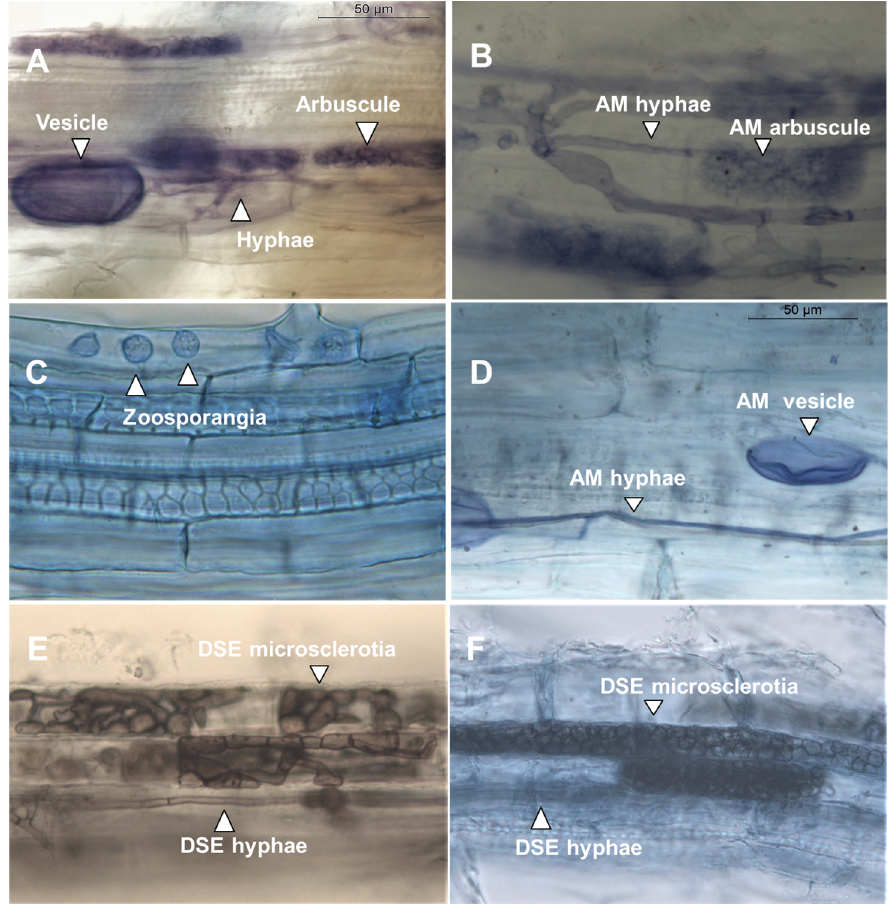
Figure 1. ( A ) Maize root cells when fertilized with digestate. Arbuscular mycorrhizal (AM) vesicle, hyphae, and arbuscule. ( B ) Maize root cells when fertilized with meat bone meal. Arbuscular mycorrhiza (AM) hyphae and arbuscule. ( C ) Oilseed rape root cells when fertilized with digestate. Olpidium brassicae zoosporangia in rhizodermal cells and ( D ) AM hyphae and vesicle. ( E ) Oilseed rape root cells without added fertilizer. Dark septate endophyte (DSE) hyphae and microslerotia. ( F ) Spelt wheat root cells when fertilized with synthetic fertilizer. DSE fungal hyphae and microslerotia. All figures are in the same scale and the bar indicates 50 µm.